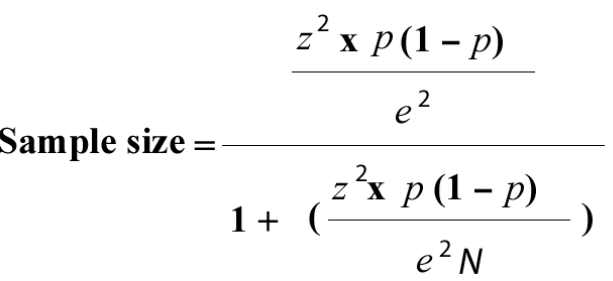
Figure 1. N: population size; z: z-score; e: margin of error (percentage in decimal form).